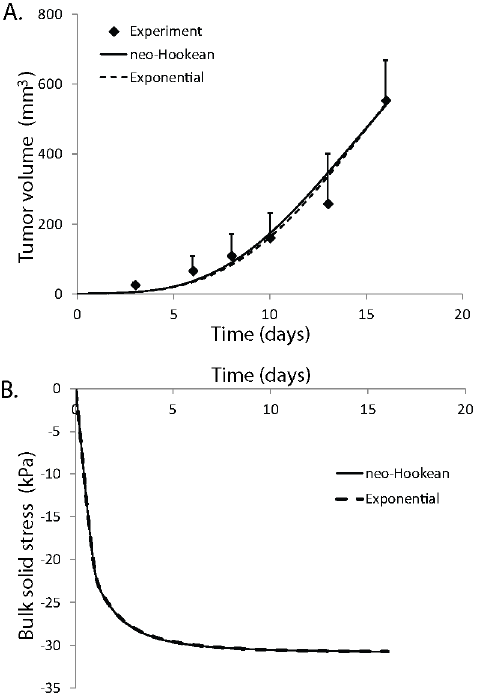
Figure 6. Effect of tumor-host mechanical interactions on tumor state of stress and growth. Dependence of A) state of stress and B) growth rate of tumors on the mechanical properties of the host tissue. The host tissue was modeled as a compressible neo-Hookean material with Poisson’s ratio of 0.2 and three values of the shear modulus were used, m =10, 15 and 30 kPa. The stiffer the host tissue is, the higher the stress in the tumor and the lower its growth rate